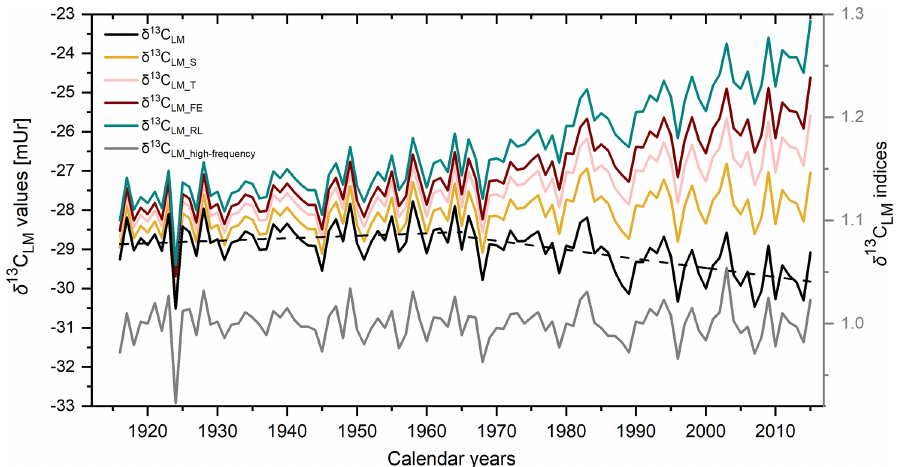
Figure 3. The mean δ 13 C LM chronology (black line). Dashed lines show the linear trends until 1965 and from 1965 to 2015. δ 13 C LM_S is the chronology after the corrections of the Suess effect, δ 13 C LM_T after additional correction of physiological response due to increasing CO 2 concentration with δ 13 C LM_T considering 0.012mUrppmv − 1 CO 2 , δ 13 C LM_FE considering 0.02mUrppmv − 1 CO 2 , and δ 13 C LM_RL considering 0.032mUrppmv − 1 CO 2 . The grey curve shows the detrended δ 13 C LM_high-frequency